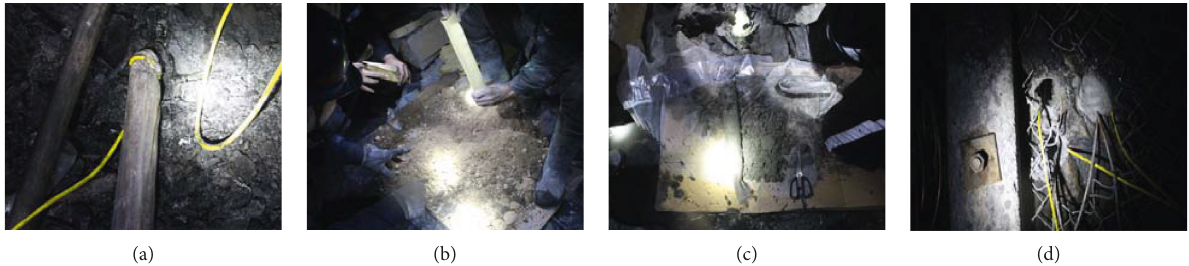
Figure 15: Cartridge and sealing material. (a) Powdery emulsion explosive binding, (b) stemming, (c) cement concrete, and (d) concrete sealing of blasting holes.